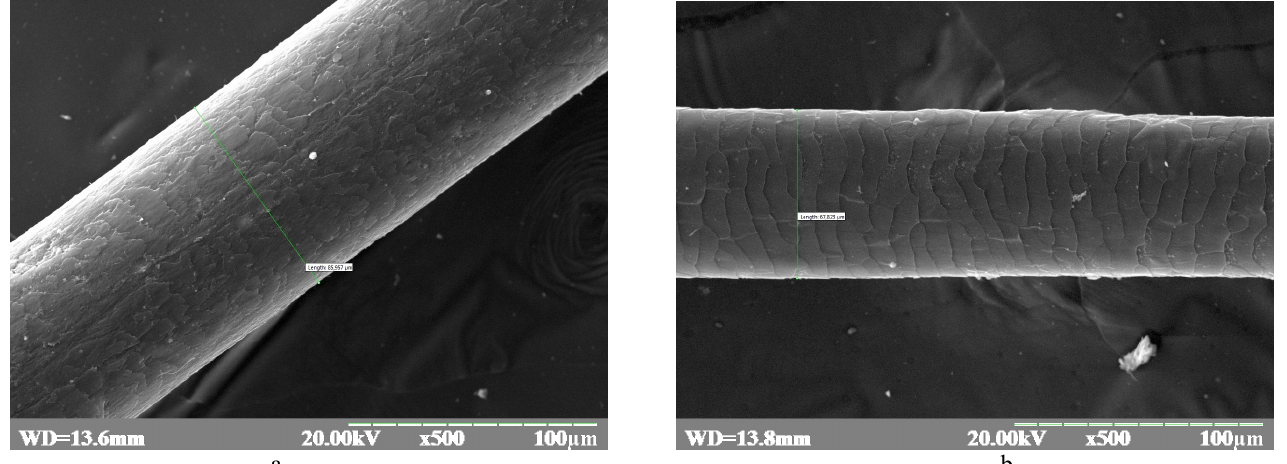
Figure 4. Donkey hair ( Equinus asinus ): а – mane; b – covering hair